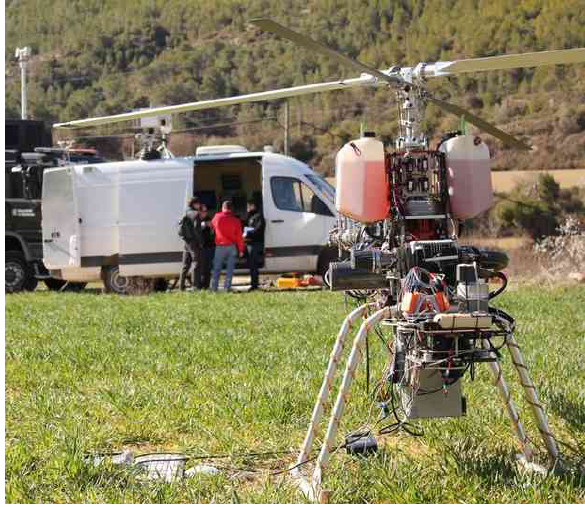
Figure 2: The CLOSE-SEARCH UAV and